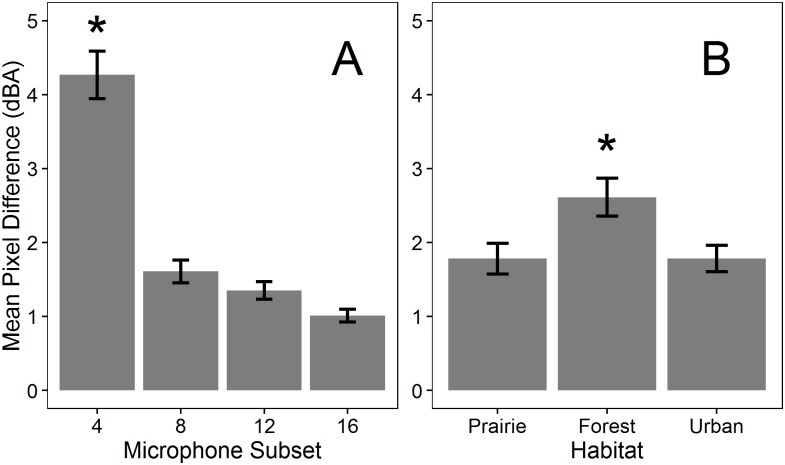
Map differences during noise introductions varied with microphone number (A) and across habitats (B).Mean pixel difference is the average difference in overall sound pressure levels (dBA) calculated by subtracting a subset map from the corresponding full array map and averaging overall all pixels. The asterisk denotes a significant difference as tested using Tukey HSD (P < 0.05). Error bars represent standard error.